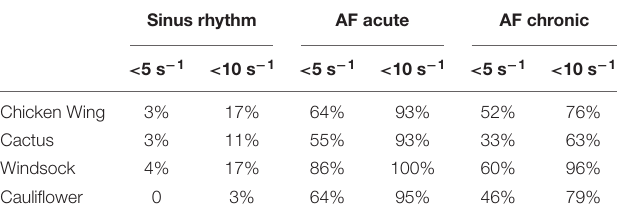
TABLE 2 | Percentage of LAA area exposed to SSR values below 10 and 5 s − 1 for the entire cycle for the different operating conditions and all models.